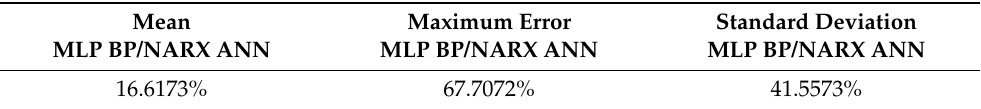
Table 5. Ratio between statistical measures: choosing of the soft sensor.